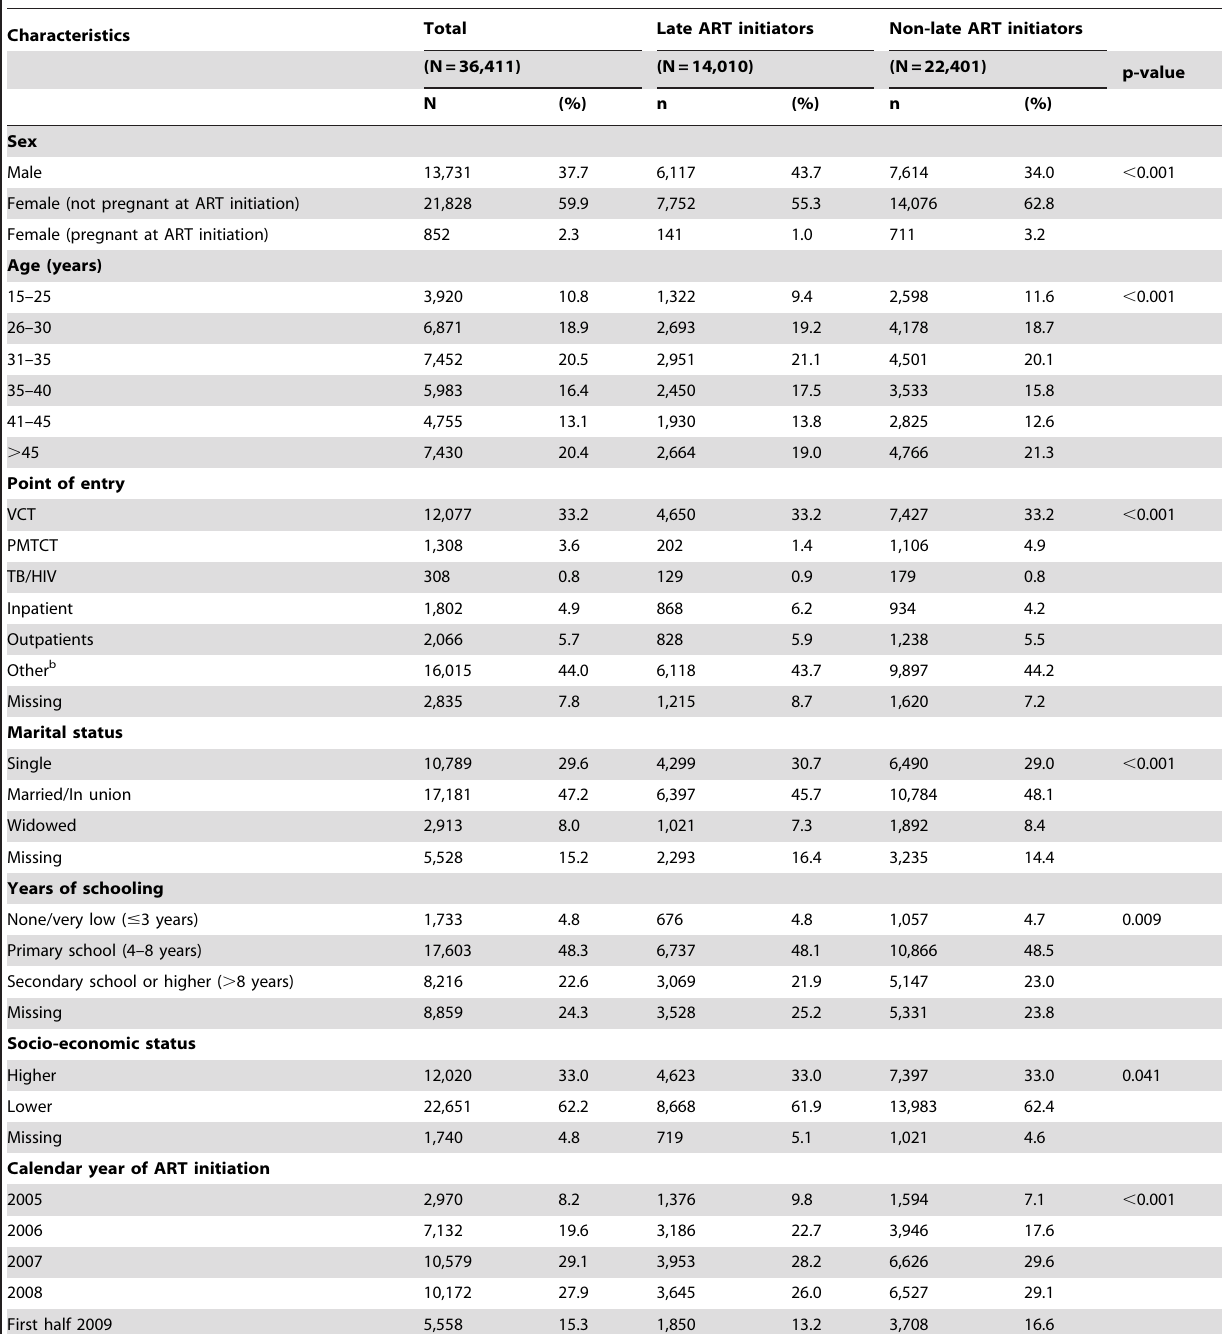
Table 1. Patient-level characteristics at ART initiation. a